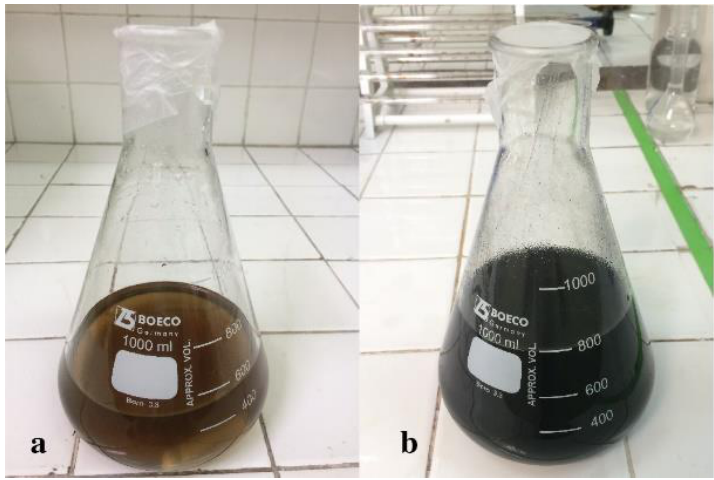
Figure 3. Color change of the mixture during the synthesis of the composites. ( a ) The suspension of GO in water had a brown tone; ( b ) the mixture turned black after reflux.